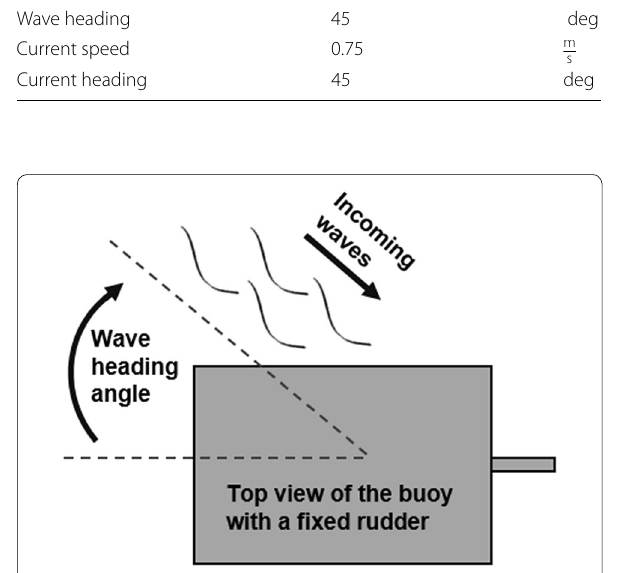
Fig. 9 Buoy with fixed rudder against lateral wave. A lateral wave with a heading of 45° is reaching the buoy with a fixed